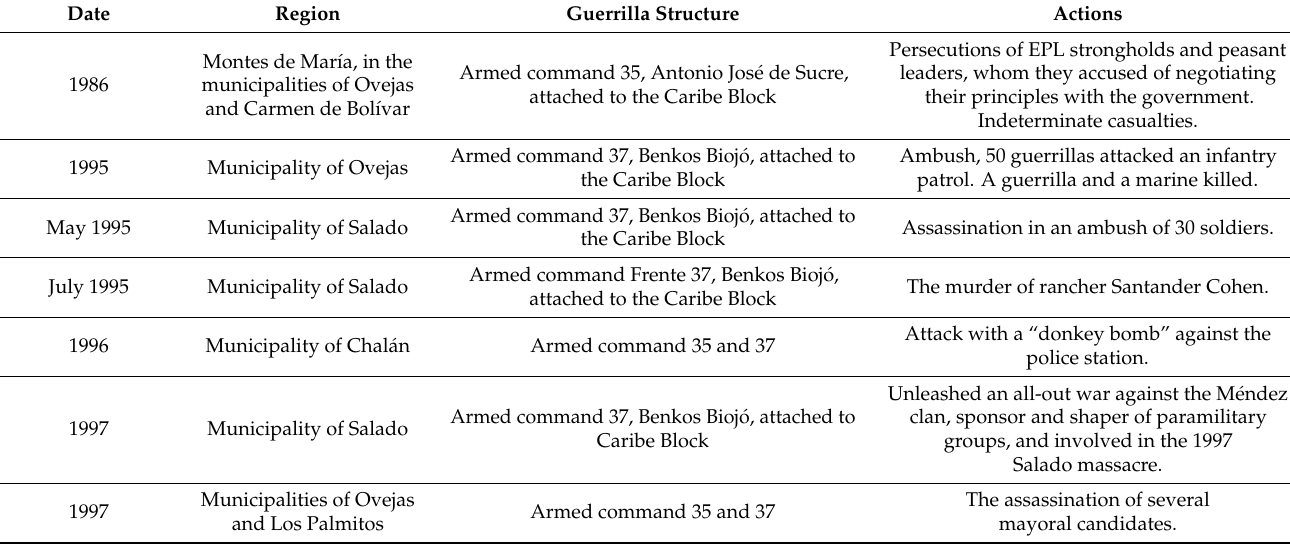
Table 2. Registry of some of the victimizing acts or armed actions of the FARC-EP in the Montes de Mar í